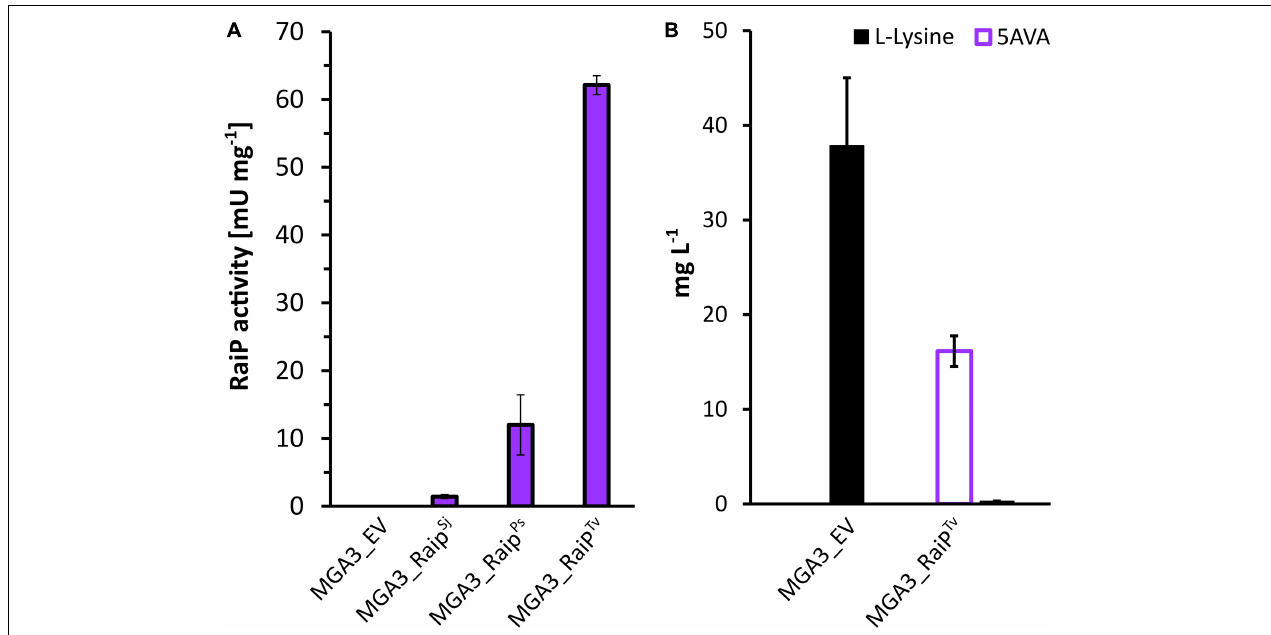
FIGURE 2 | Evaluation of RaiP enzyme activity (A) and amino acids production (B) in recombinant B. methanolicus strains. B. methanolicus strains MGA3_EV, MGA3_RaiP Sj , MGA3_RaiP Ps , or MGA3_RaiP Tv were cultivated in a shaking flask culture. The grown cells were harvested, washed twice with 50 mM phosphate buffer (pH 7.0), and disrupted by sonication. After centrifugation, the crude extracts were directly used for the RaiP assay. MGA3_EV and MGA3_RaiP Tv were cultivated for 27 h, and supernatants were obtained by centrifugation for HPLC analysis. The error bars represent standard deviation of technical triplicates.